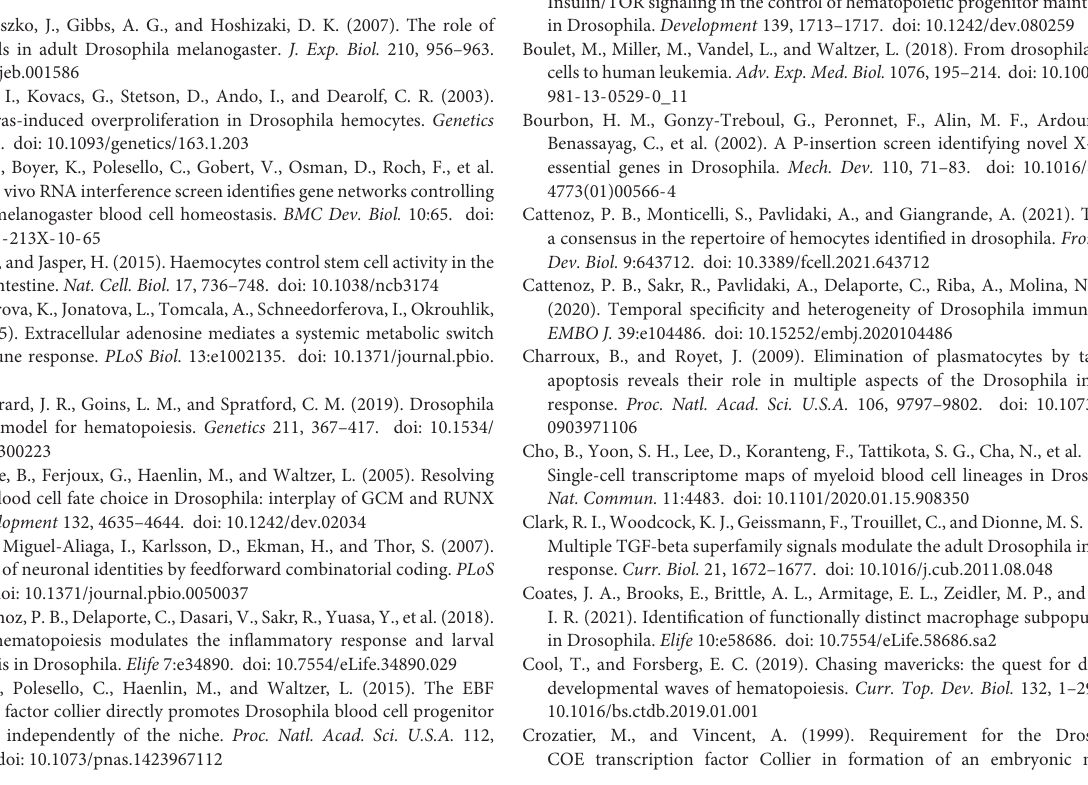
Supplementary Table 6 | List of differentially expressed genes between adult, larval peripheral and lymph gland blood cells (fold change > 2, adjusted p -value < 0.01).